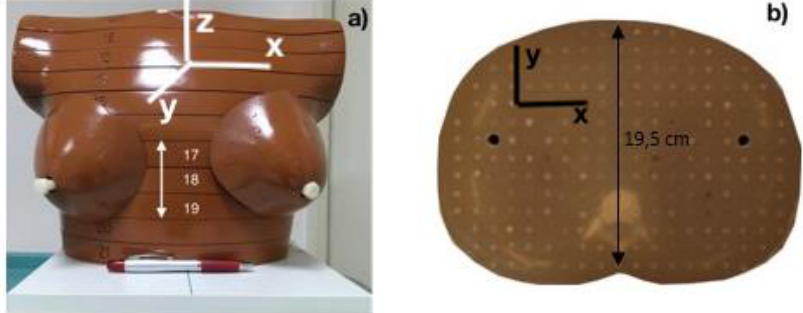
Figure 1. Alderson Rando TM woman anthropomorphic phantom: ( a ) front view and measurement area; ( b ) top view of a slab. The scan axis is along the z direction while x–y is the axial plane. XR-QA2 films samples were cut in 4 cm × 8 cm pieces and applied onto the surface of the 17th, 18th and 19th phantom slabs, as in Figure 2a–c. A CT scan was then carried out. In particular, a four-slice CT scanner (GE Lightspeed) was used to scan the area between the 17th and 19th phantom slabs along the z -axis. The scan parameters were helical mode, AEC system, isocenter in the 18th phantom slab; length of scan equal to 153.75 mm; 3.75 mm slice-thickness; 140 kVp and pitch equal to 1. The same CT scan was repeated other 5 times, after placing the TLDs on the surface of the 17th, 18th and 19th slabs, in the position identified in Figure 2a–c, by the white points.